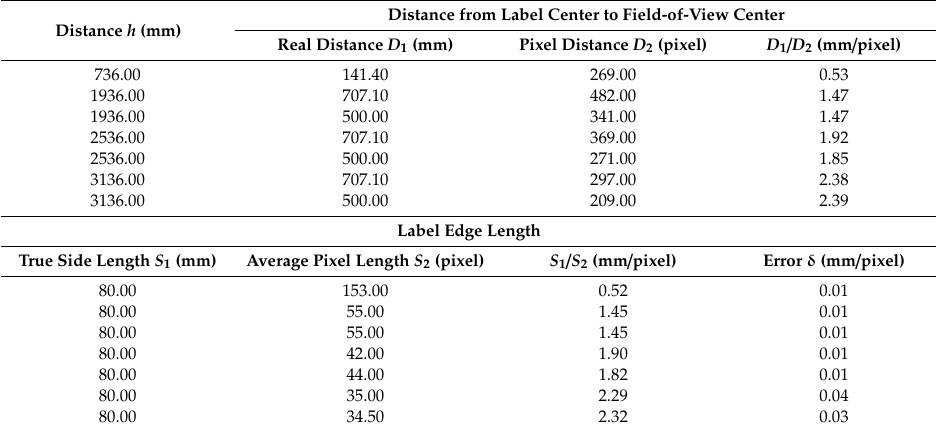
Table 3. Distance test results of the image label (80 mm × 80 mm).